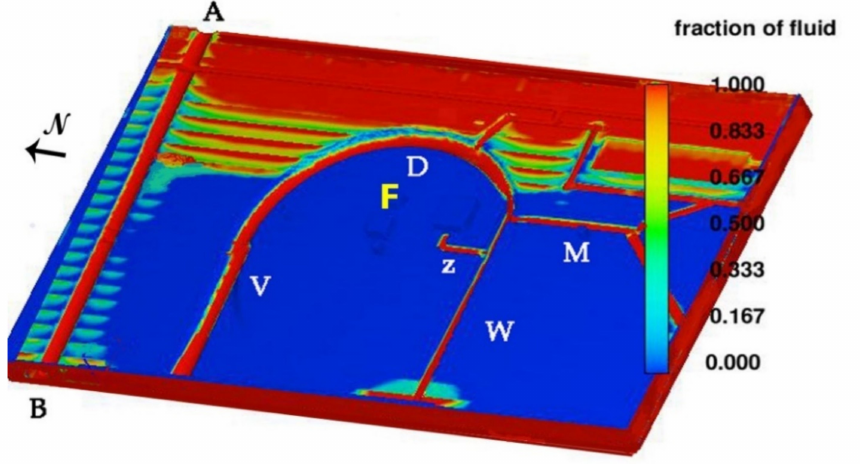
Figure 7. Later time fluid fraction surface drying achieved by aquifer seepage and surface evaporation at the end of the rainy season; note that channel M continues to provide water flow to subterranean P and Q channels and the perimeter channel bottom. Note low values of fluid fraction starting eastward on the drying ground surface for Case 1 conditions as the dry season